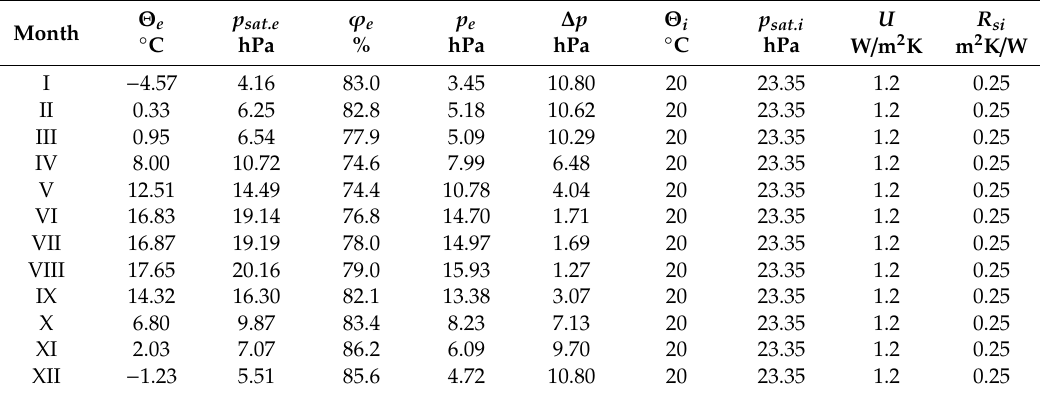
Table 5. Parameters of external and internal climate and building barrier.